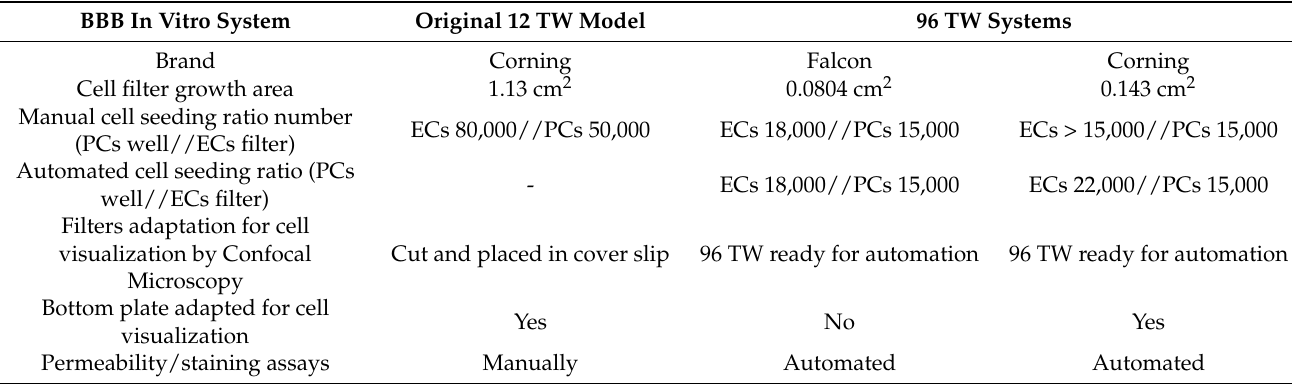
Table 2. Descriptive and comparative summaries of the human BBB in vitro model development and processing: original 12-well TW model and the miniaturized and automated 96 TW system replicates.